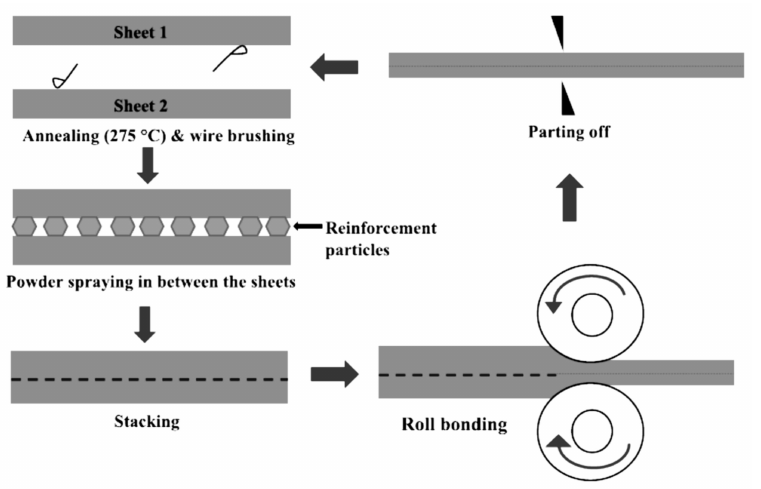
Figure 1. Schematic representation of nanocomposite sheets manufacturing through the ARB process.